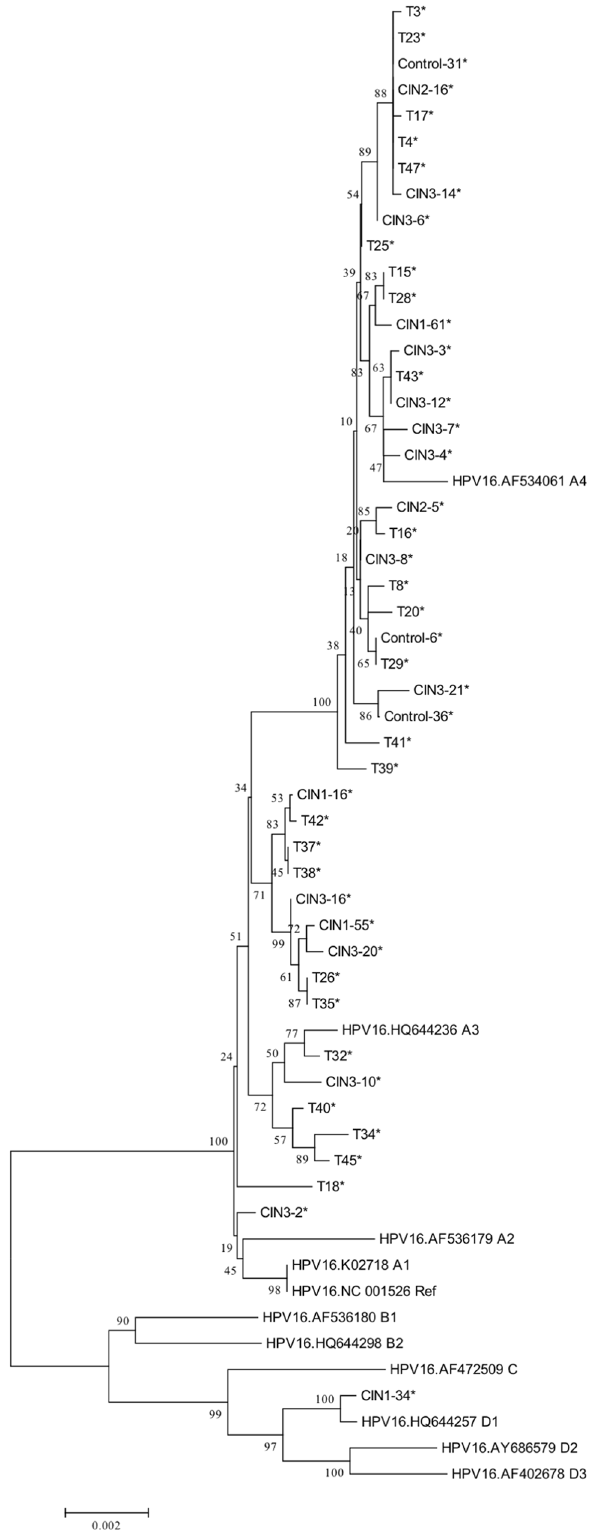
Figure 1. Phylogenetic tree based on whole-genome analyses of 46 HPV16-positive samples and 11 sequences from the Genbank database. Phylogenetic analyses were conducted using the neighbor-joining algorithm implemented in MEGA software (version 6). Bootstrap analysis of 1000 replicates was performed on each tree to determine the confidence. Study sequences in the phylogenetic trees were marked with an